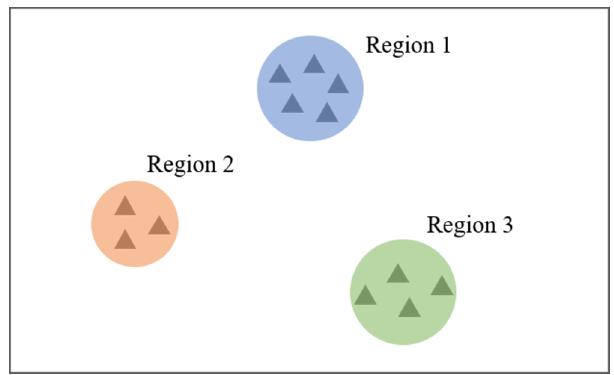
Figure 1. Illustration of spatial patterns.